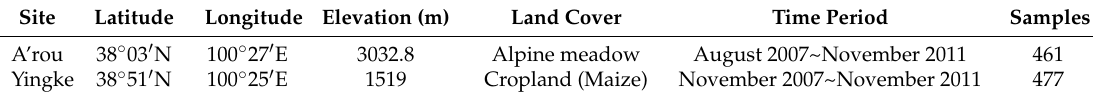
Table 1. Characteristics of the two validation sites and the acquisition period of in situ